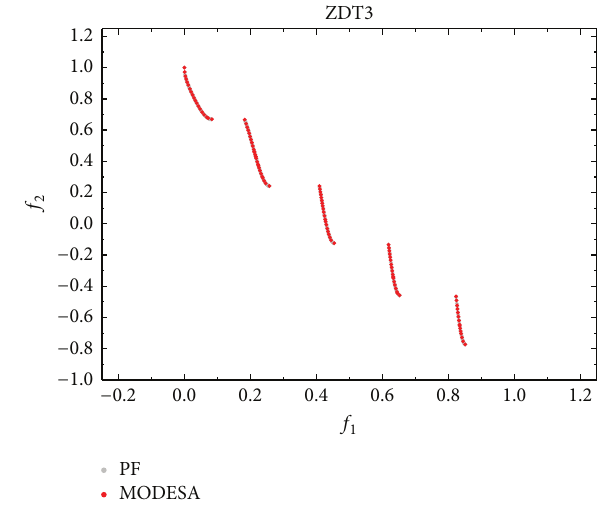
Figure 3: Plots of the nondominated solutions with the lowest IGD- metric values found by MODESA in 10 runs in the objective space on ZDT3 where 𝑁 = 100 and 𝑇 = 250 .